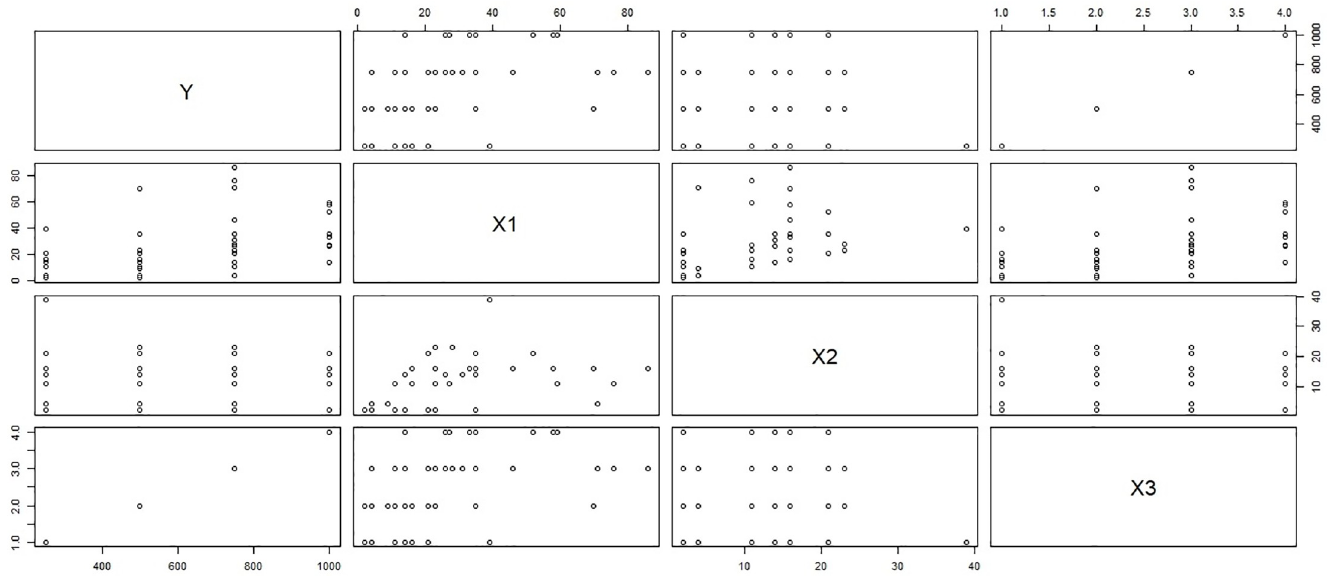
Fig 2. Behavior of respondents with λ 2 =